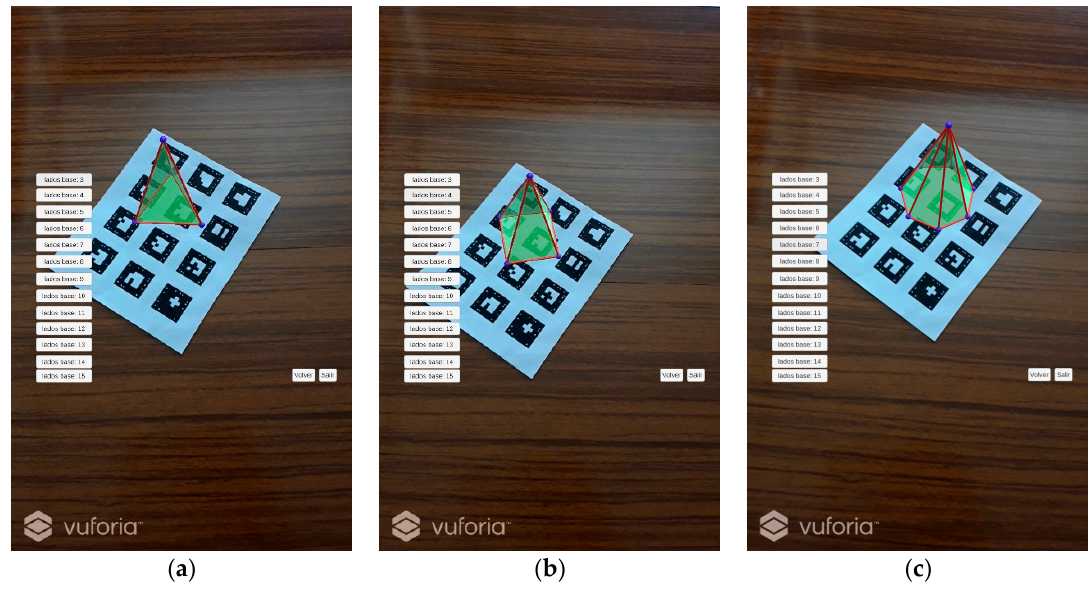
Figure 4. Images of regular pyramids with AR application. ( a ) Pyramid with a triangle base; ( b ) Pyramid with a square base; ( c ) Pyramid with an octagonal base.